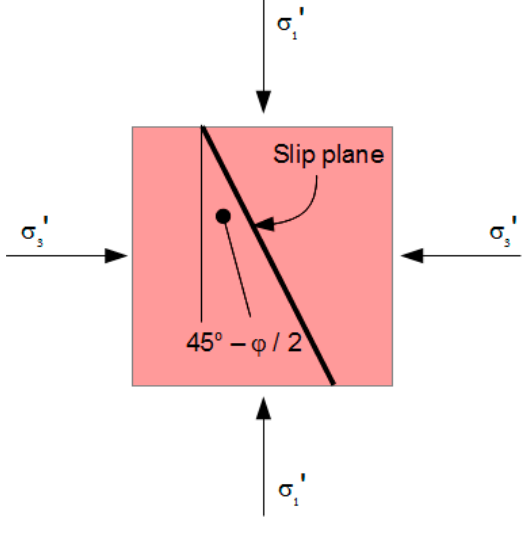
Figure 4. The Slip Plane.